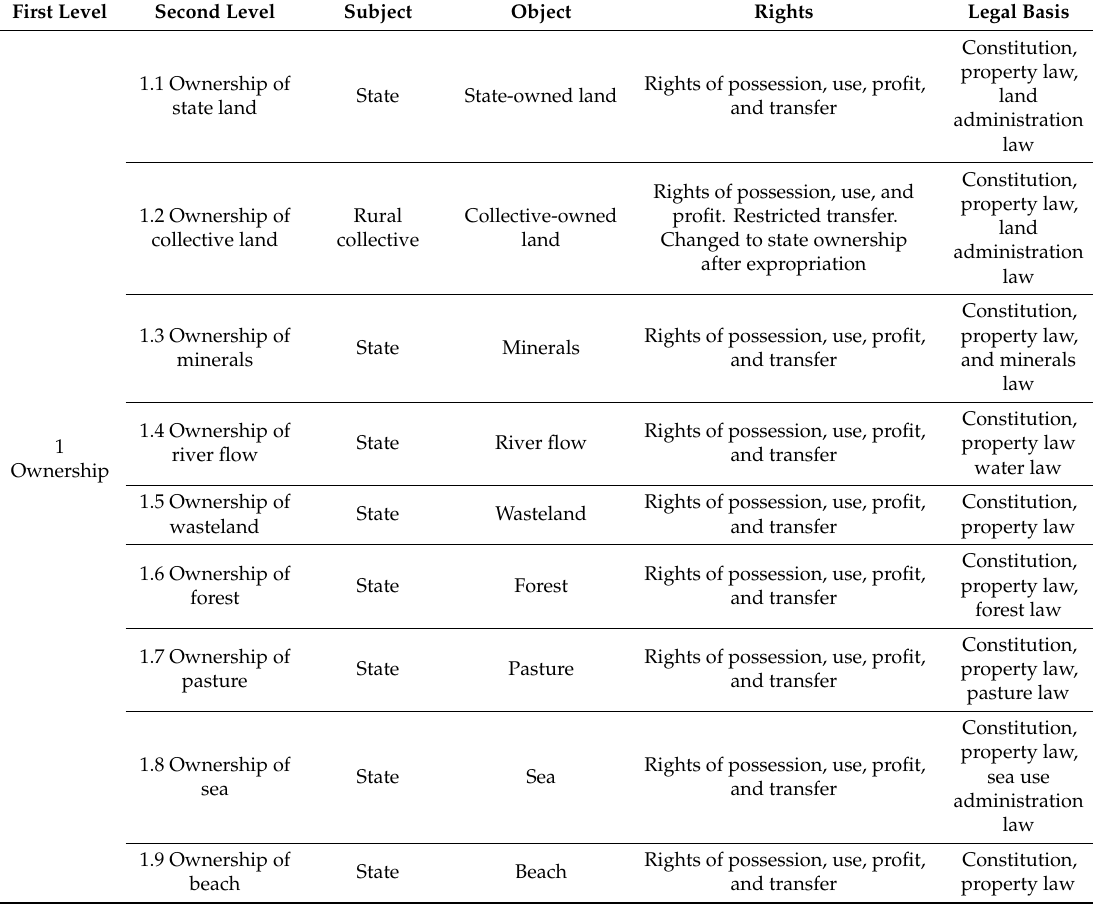
Table A3. Structure of the private rights of natural resource